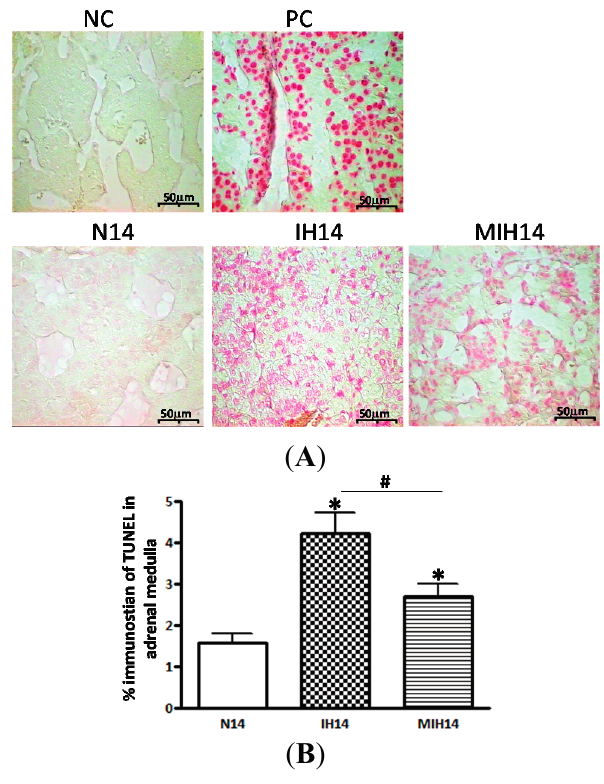
Figure 5. TUNEL-staining of apoptotic cells in the adrenal medulla was increased in the hypoxic groups (IH and MIH group) but the increase was less in the MIH group. ( A ) TUNEL-staining in sections of the adrenal medulla in Nx, IH and MIH groups; and ( B ) Summary of % TUNEL-staining in the adrenal medulla. Calibration bar is 20 μ m. (* p < 0.05, versus normoxic control; # p < 0.05, versus IH group. n = 6 per group). NC, negtive control; PC, positive control; Nx, normoxic control; IH, intermittent hypoxia; MIH, melatonin-treated intermittent